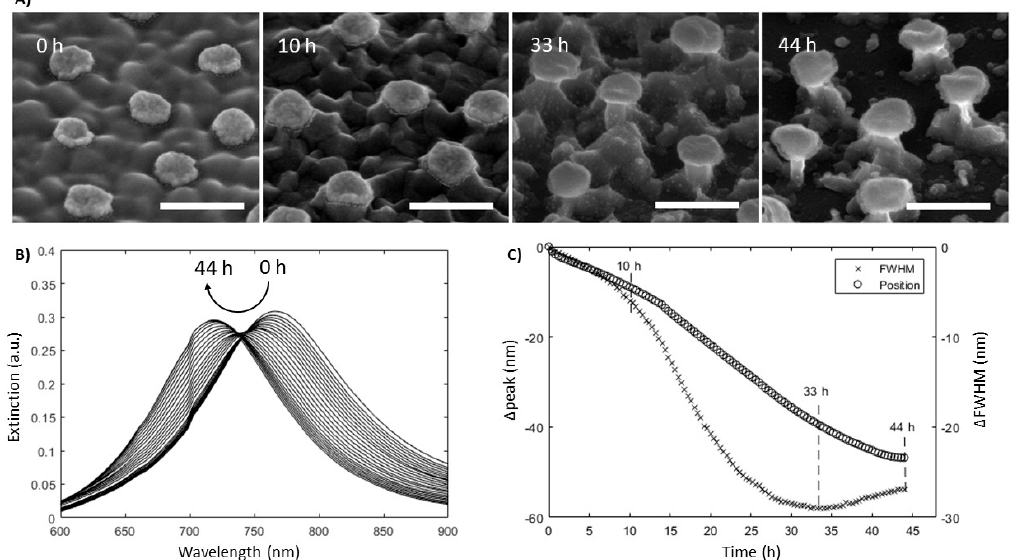
Figure 2. Etch assay of gold nanodisk-patterned ITO substrates. ( A ) SEM images at selected times during etching taken at a 45° angle showing evolution of gold disks on ITO pin-like structures. 44 h-sample was coated with 5 nm titanium, because the ITO film was etched down to the underlying glass substrate, breaking electrical conductivity in the film. Scale bars are 200 nm. ( B ) Raw spectra showing gold nanodisk resonance peaks during etching. Individual spectra are spaced two hours apart. The curved arrow shows evolution of the peak positions. ( C ) Spectral shift and width of the plasmonic resonance plotted as a function of the etching time. The width reaches a minimum around 33 h into the etch assay. The peak position appears to reach a minimum after 44 h.